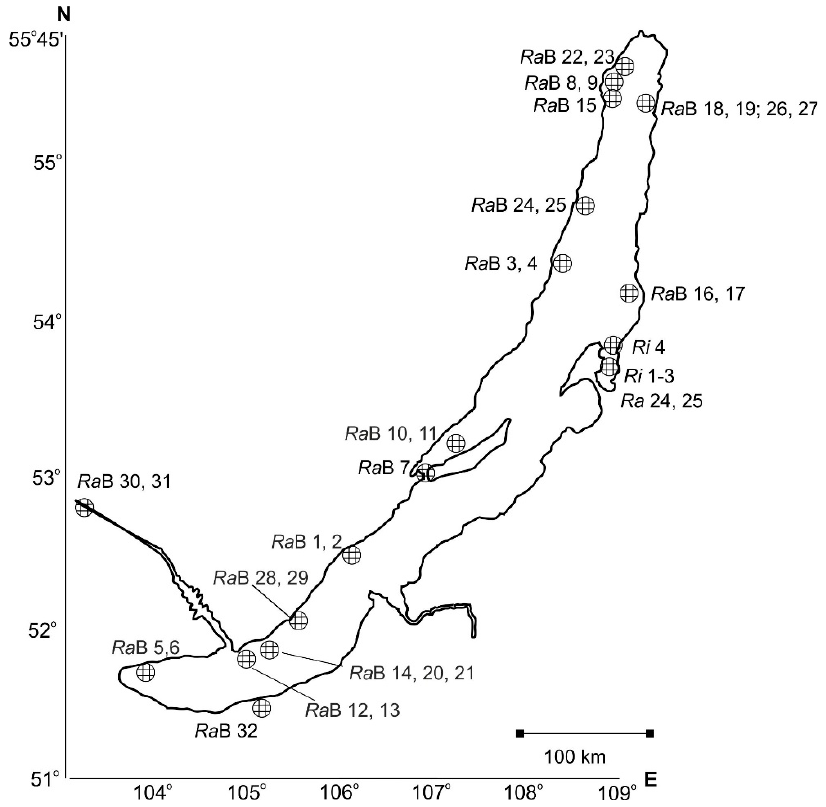
Figure 1. A map of Lake Baikal indicating sampling sites of molluscs used in this study. Numbers correspond to the numbers of Radix samples in Supplementary Table S1. RaB— R. auricularia from Lake Baikal; Ri— Radix intercisa ; Ra— R. auricularia.